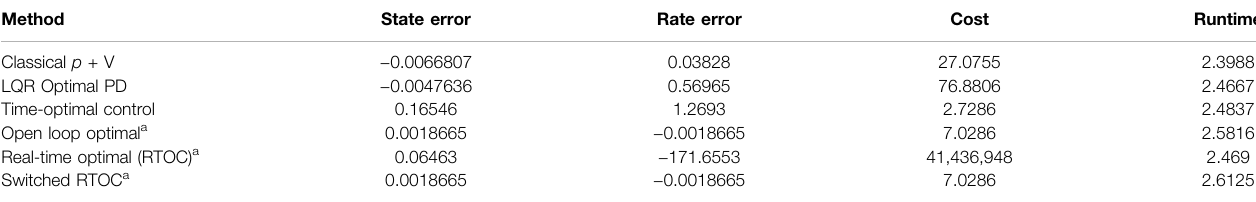
TABLE 12 | Double-integrator plant ( with transport theorem) with control design based off double-integrator with transport theorem and noisy, mixed sensors (state and rate): sub-displays the quantitative comparative data corresponding to the qualitative display in sub- Figure 6 . Method